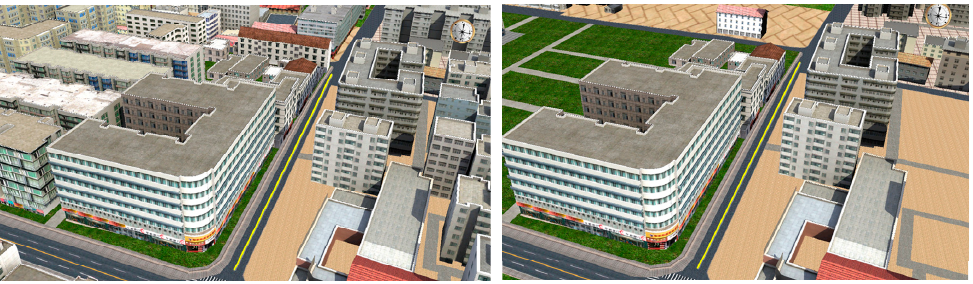
Figure 10. The comparison between the grid-based (on the left ) and the movement-based (on the right ) 3D model management method.